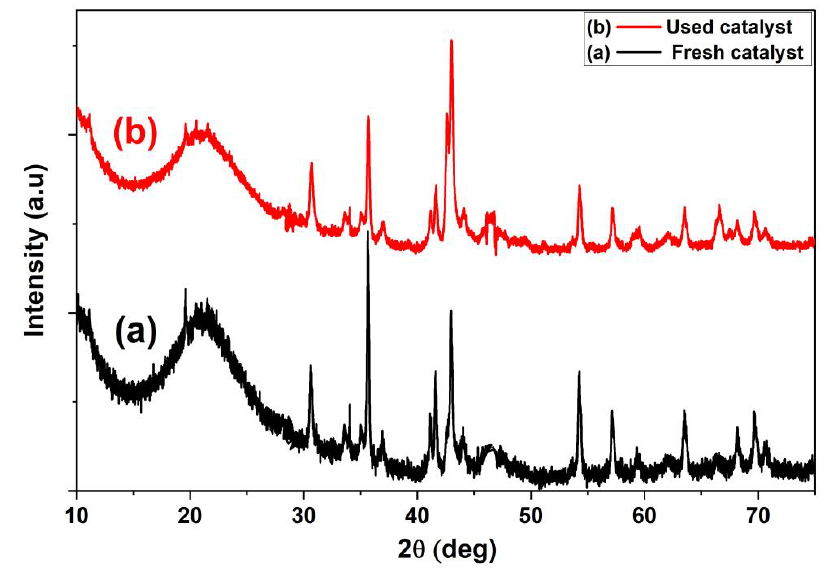
Figure 13. Effect of reuse on the structure of 45 NFAC catalyst using XRD pattern.